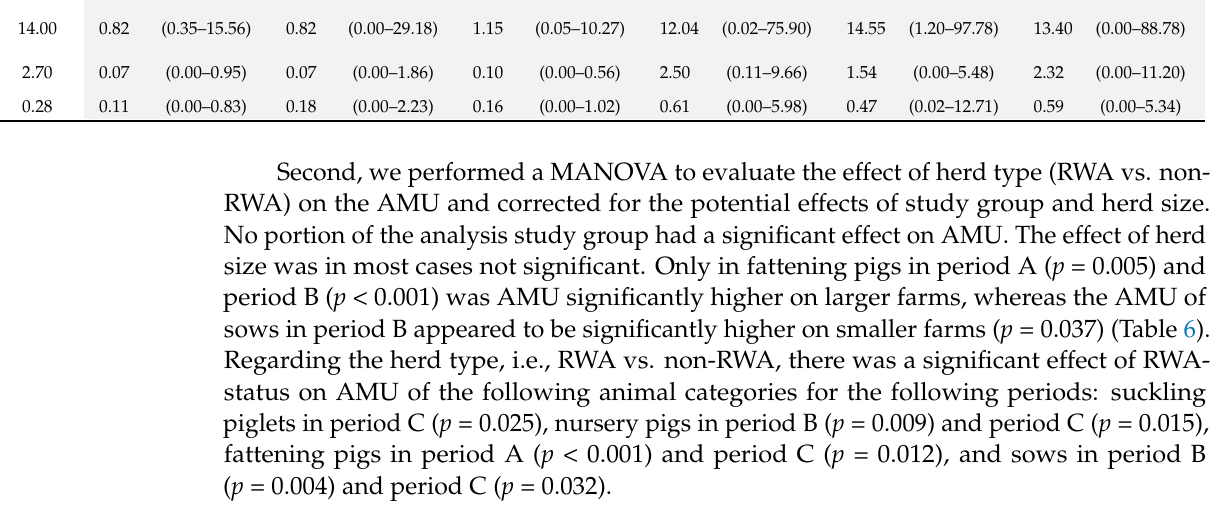
Table 6. The median (min.–max.) BD100 of the animal categories where a significant effect of herd size on AMU was found. Farms were categorized into two groups; namely, farms with a herd size smaller than the median for the corresponding period and farms with a herd size equal to or larger than the